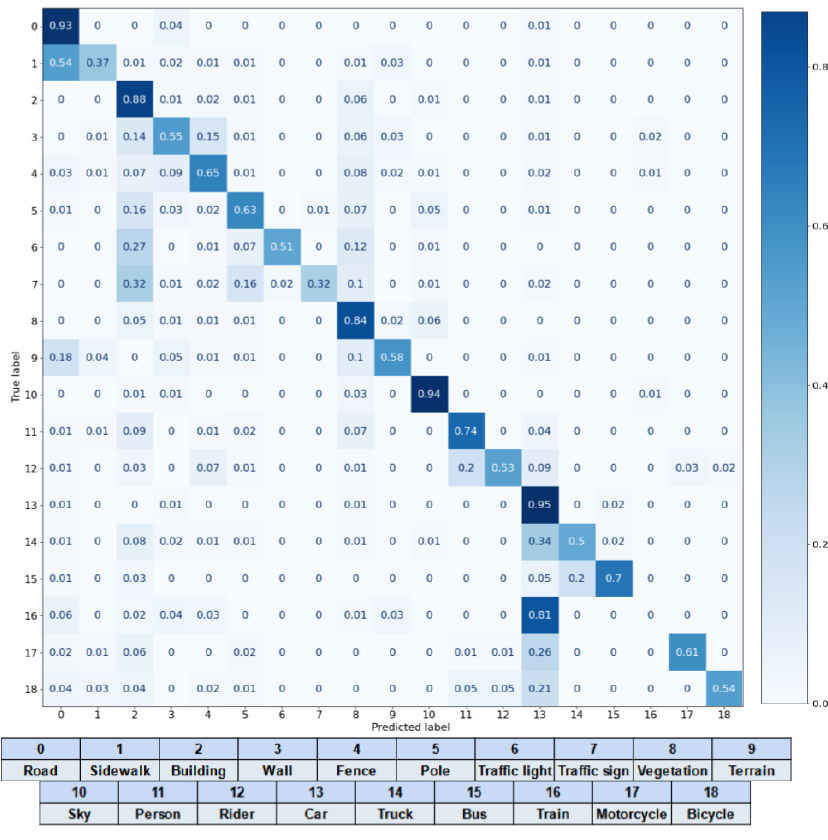
Figure A2. Confusion matrix of the co-training model trained with GTAV + Synscapes as source data and BDD100K as target data. Figure A3 is analogous to Figure A1 but for Mapillary Vistas as target